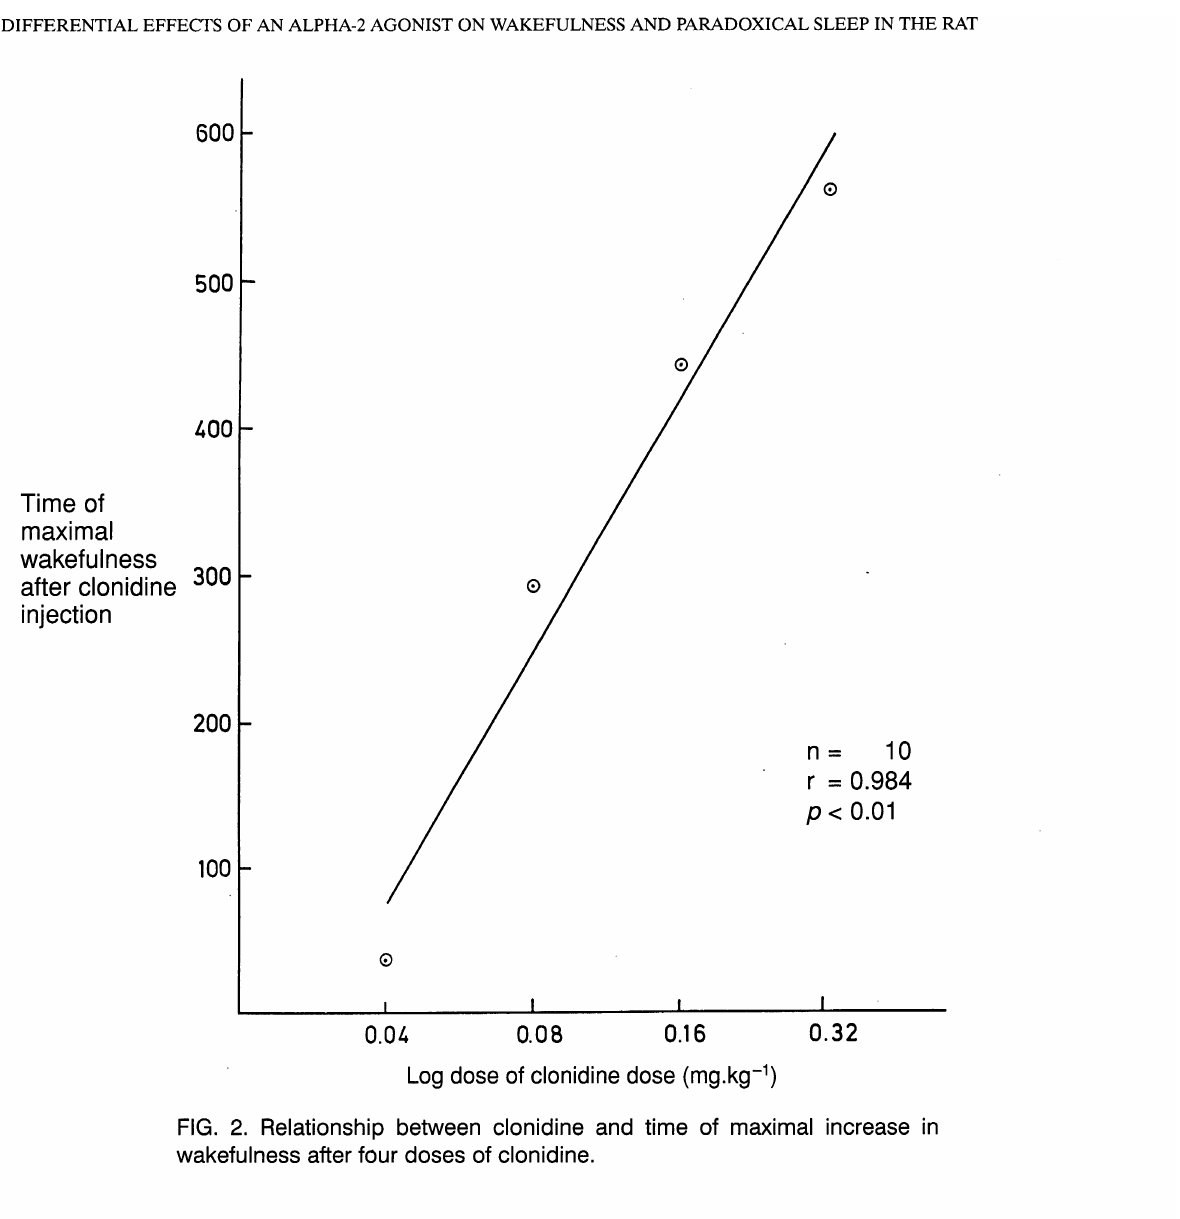
FIG. 2. Relationship between clonidine and time of maximal increase in wakefulness after four doses of